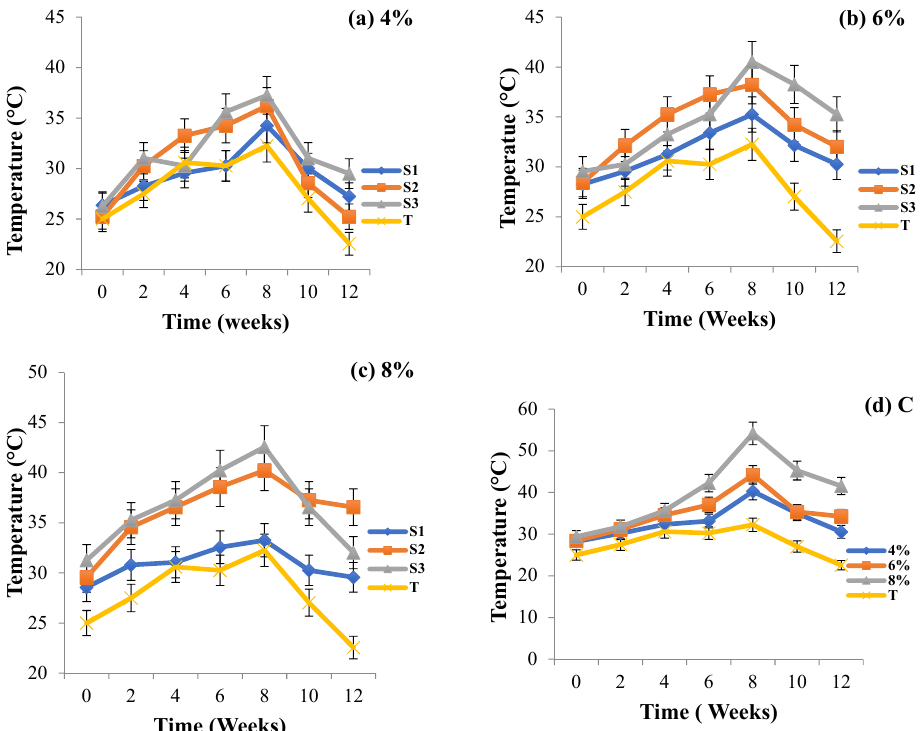
Figure 2. Evolution of temperature ( ◦ C) of the three strains isolated and their consortium as function of the time at different inoculum doses (4% ( a ), 6% ( b ), and 8% ( c )), T; negative test. S1: Strain 1; S2: Strain 2; S3: Strain 3; ( d ) C: Consortium.